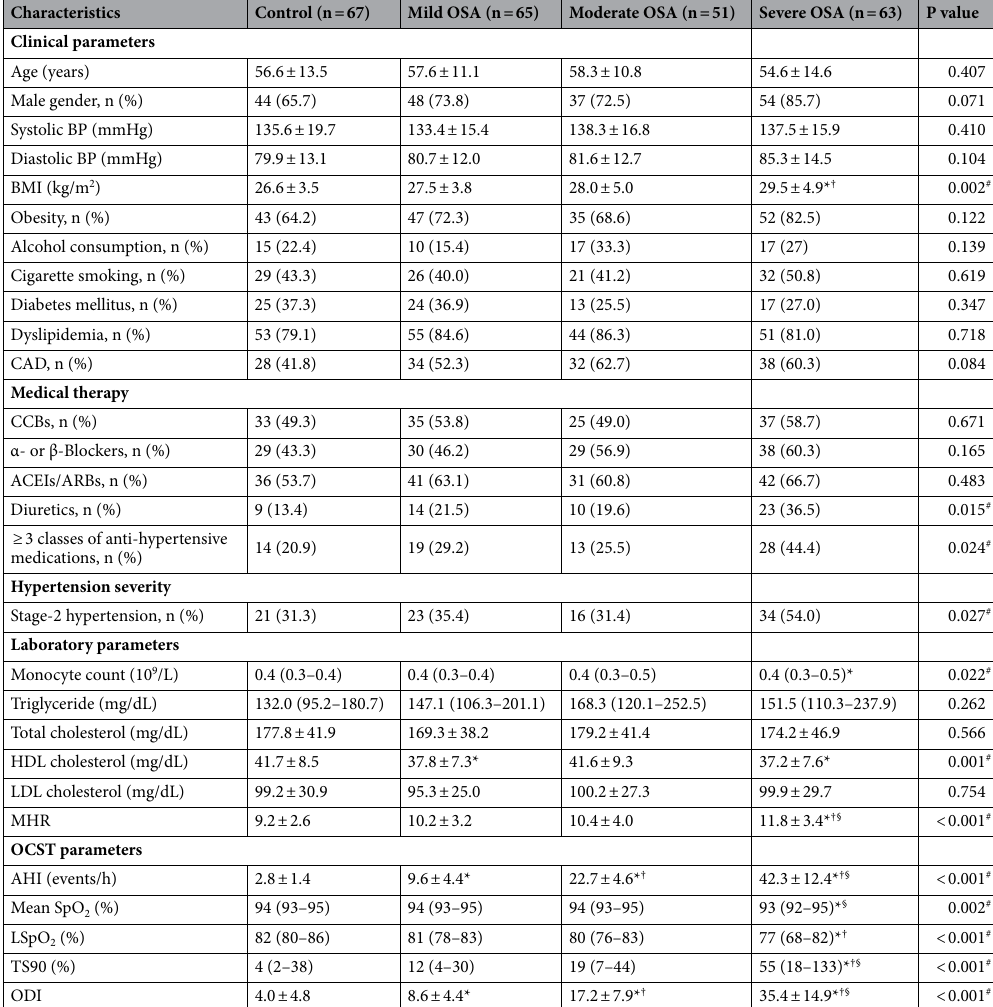
Table 2. Baseline clinical, laboratory, and OCST data of the study population. Data are means ± standard deviation, numbers of subjects (%), or medians (range). OSA obstructive sleep apnea, BP blood pressure,